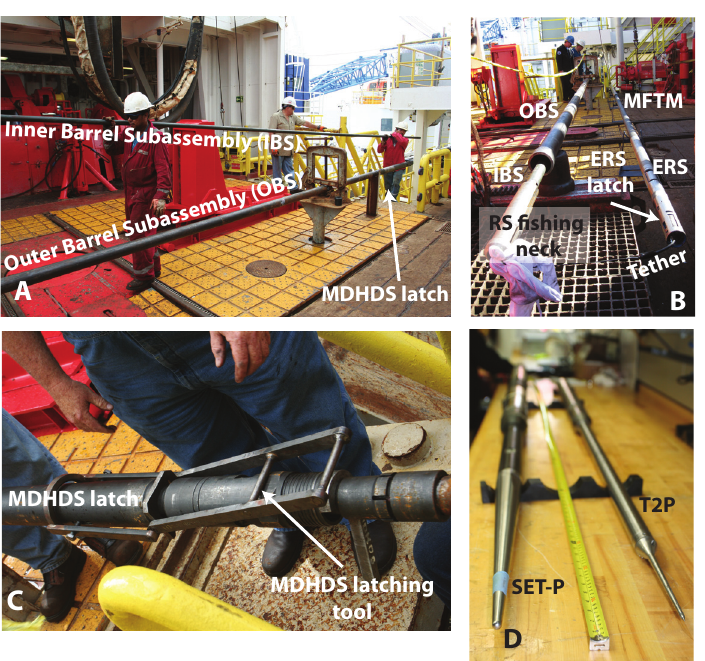
Figure 2. [A] The Inner Barrel Subassembly (IBS) and the Outer Barrel Subassembly (OBS). [B] Left: the IBS lies inside the OBS. The fishing neck of the IBS is shown on the lower left. Right: the ERS is connected to the MFTM, which is connected to the logging line. The ERS Latch is at the bottom of the ERS assembly. [C] The MDHDS Latch and latching tool. The latch is set on the rig floor, and this fixes the IBS to the OBS. When the drillstring is pressurized, this latch is released, and the IBS slides freely from the OBS. [D] The SET-P and the T2P are two pore pressure penetrometers available for use in the drilling